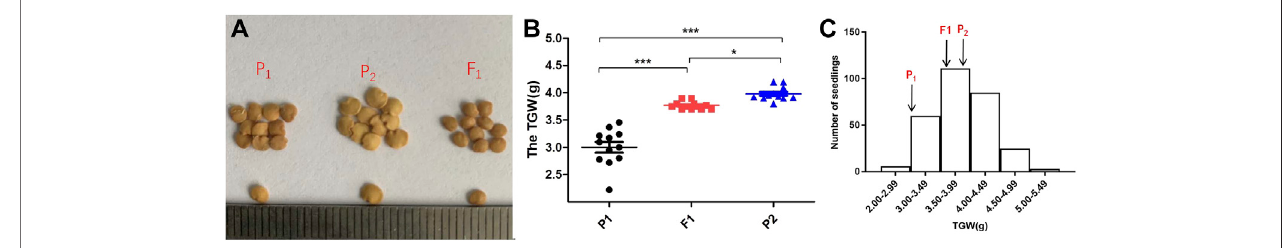
FIGURE 1 | The phenotypic in parents, F1and segregating populations. (A) : Performance of the size of the parents (17c01 and 17c02) and the F1. (B) : The differencesdistributionofaverageTGWofP1,P2andF1population. (C) :FrequencydistributionoftheTGWintheF2population.ArrowsindicatetheTGWofP1,P2and the F1 population.